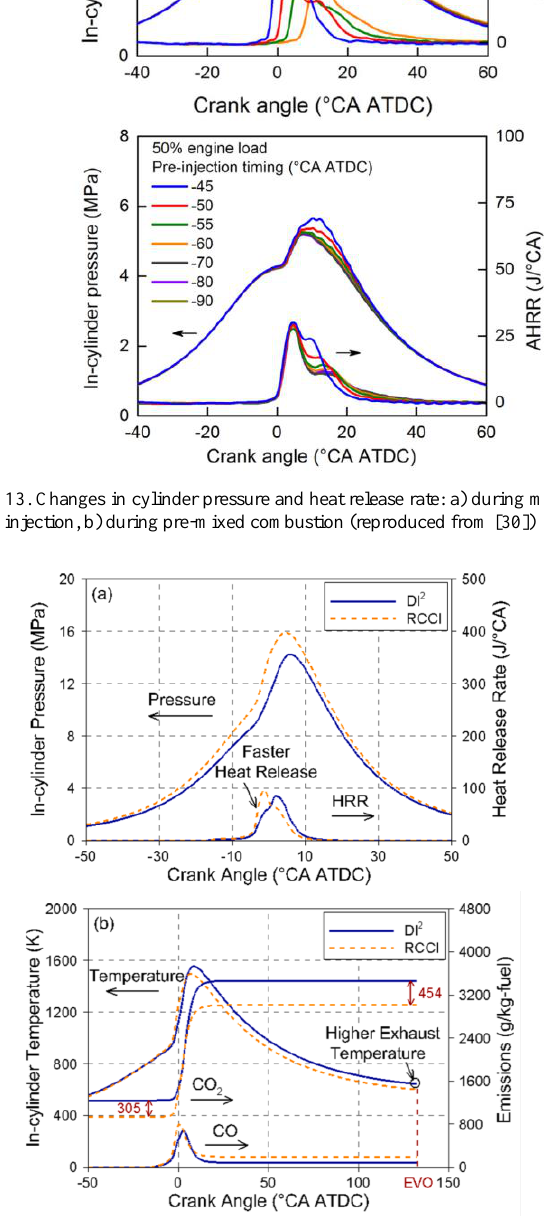
Fig. 14. In-cylinder pressure, heat release rate, temperature, CO, and CO 2 emission characteristics for representative cases of DI 2 and RCCI (repro- duced from [9)]